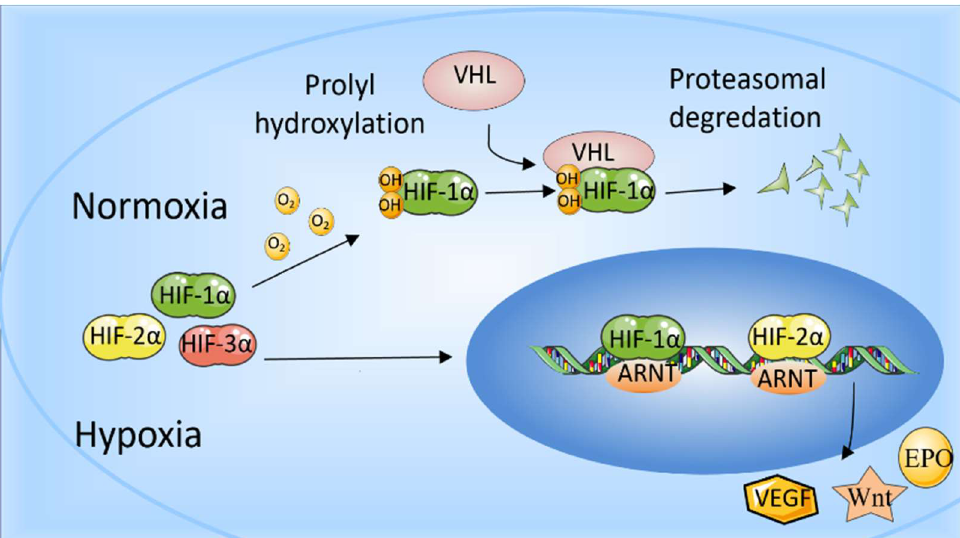
Figure 1. The role of HIF-1α and HIF-2α. When oxygen levels are low (hypoxia), HIF-1α and HIF-2α are protected from degradation and accumulate in the nucleus, where they bind to ARNT and bind to specific DNA fragments in hypoxia regulatory genes. At normal oxygen levels, oxygen regulates the degradation process by adding hydroxyl groups to HIF-αs. VHL recognizes and forms a complex that carries HIF-αs and degrades them in an oxygen-dependent manner. Table 1. HIF-1 functions through regulating different signals in different animal models or